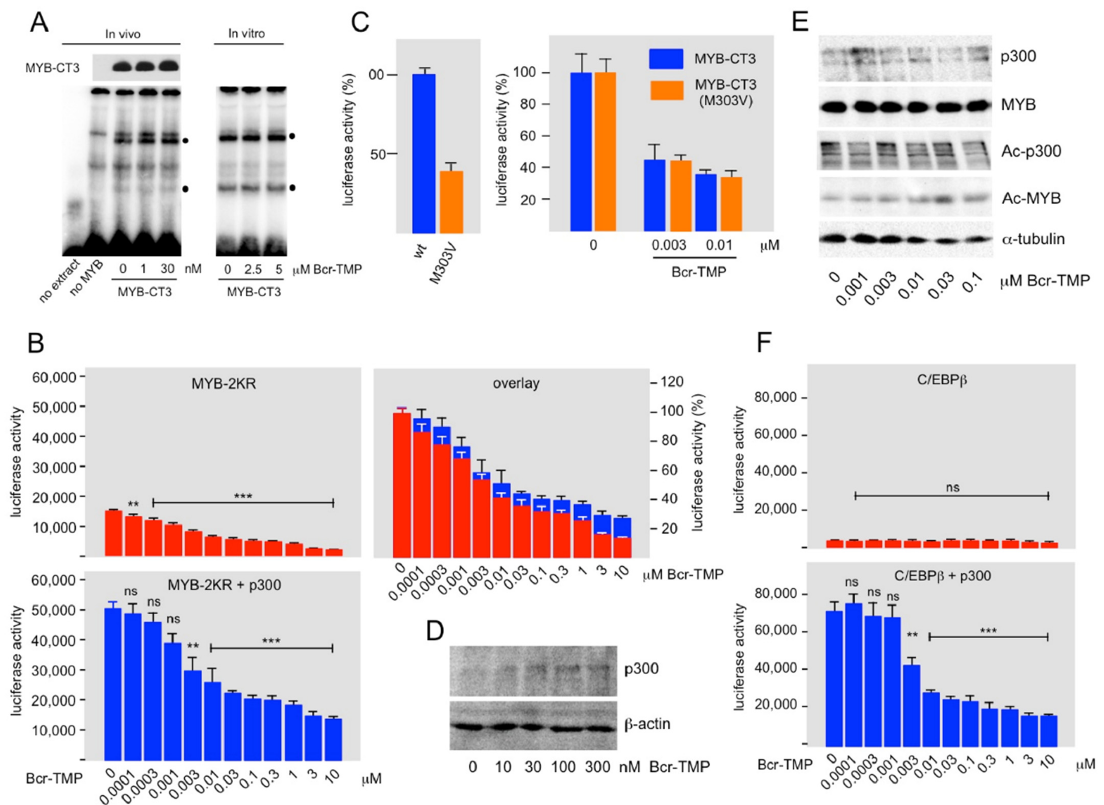
Figure 2. Bcr-TMP suppresses MYB activity in a p300-dependent manner. ( A ) EMSA assay with nuclear extracts from HEK293T cells expressing MYB-CT3, as marked below the lanes, and cultivated for 16 h with the indicated concentrations of Bcr-TMP. Nuclear extract from un-transfected cells was used as control. A Western blot showing MYB-CT3 expression in aliquots of the nuclear extracts is presented at the top. Binding assays were performed with a radiolabeled oligonucleotide containing a consensus MYB binding site. MYB-specific protein-DNA-complexes are labeled by black dots. In addition to using nuclear extracts from cells treated with Bcr-TMP in vivo, EMSA assays were per- formed by adding compounds directly to the in vitro binding reactions (last three lanes). ( B ) HEK293T cells were transiently transfected with the MYB-dependent reporter plasmid pGL4-5xMRE(GG)-Myc and expression vectors for MYB-2KR and p300, as shown at the top. Transfected cells were treated with Bcr-TMP for 16 h and subjected to luciferase assays. The columns show the absolute luciferase values in arbitrary numbers and the panel on the right (overlay) shows the luciferase activity nor- malized to that of untreated cells. ( C ) The left panel shows the luciferase activity of HEK293T cells transfected with reporter plasmid pGL4-5xMRE(GG)-Myc and expression vectors for MYB-CT3 and MYB-CT3(M303V). The right panel shows the luciferase activity of HEK293T cells transfected in the same manner and treated without or with the indicated concentrations of Bcr-TMP for 16 h before harvesting and measuring luciferase activities. The difference in activity between MYB-CT3 and the M303V mutant was compensated by expressing the luciferase activities as percent of the activity of the untreated cells. ( D ) Expression of endogenous p300 in HEK293T cells treated for 16 h with or without Bcr-TMP. ( E ) HEK293T cells transfected with expression vectors for MYB-2KR and p300 were treated for 16 h with Bcr-TMP, as indicated at the bottom. Total cell extracts were then analyzed by Western blotting for expression of p300, MYB-2KR, acetylated p300, acetylated MYB-2KR, and β -actin. ( F ) HEK293T cells were transiently transfected with the C/EBP-dependent reporter plasmid pmim3mim-Luc and expression vectors for human C/EBP β and p300, as indicated. Transfected cells were treated with Bcr-TMP for 16 h and subjected to luciferase assays. The columns show the absolute luciferase values in arbitrary numbers. Asterisks in panels B and F indicate statistical significance (ns: non-specific; ** p < 0.01; *** p < 0.001; Student’s t -test). The uncropped Western blots have been shown in Figure